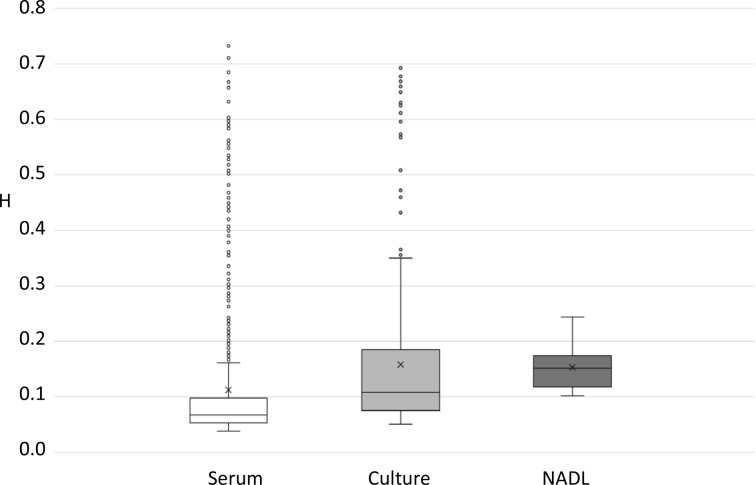
Boxplots of the Shannon entropy values (H) for qualifying SNPs in each of the three genome sequences: MRI103-serum (white boxes, 824 SNPs), MRI103-culture (light grey boxes, 407 SNPs) and NADL (dark grey boxes, 12 SNPs). For each plot, the first and fourth quartiles are shown as bounded vertical lines, the second and third quartiles are shown as boxes separated by a line representing the median value, outliers are included as circles and the mean value is marked with a cross (X).